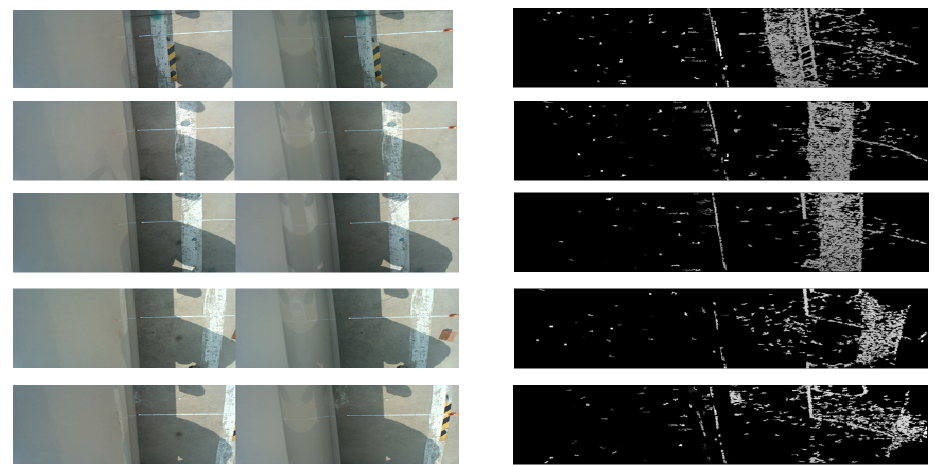
Figure 20. Experimental diagram of binocular camera static distance measurement.